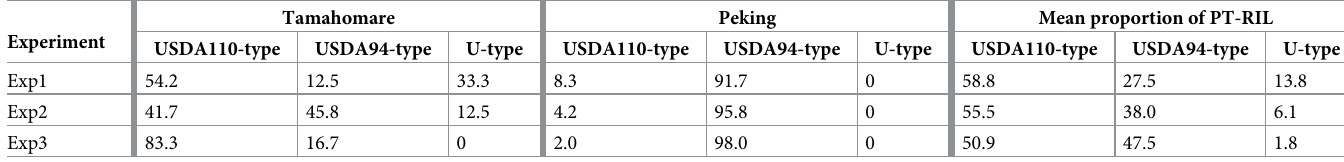
Table 1. Proportion (%) of bacterial types in nodules from Tamahomare, Peking and RILs from the three independent experiments.